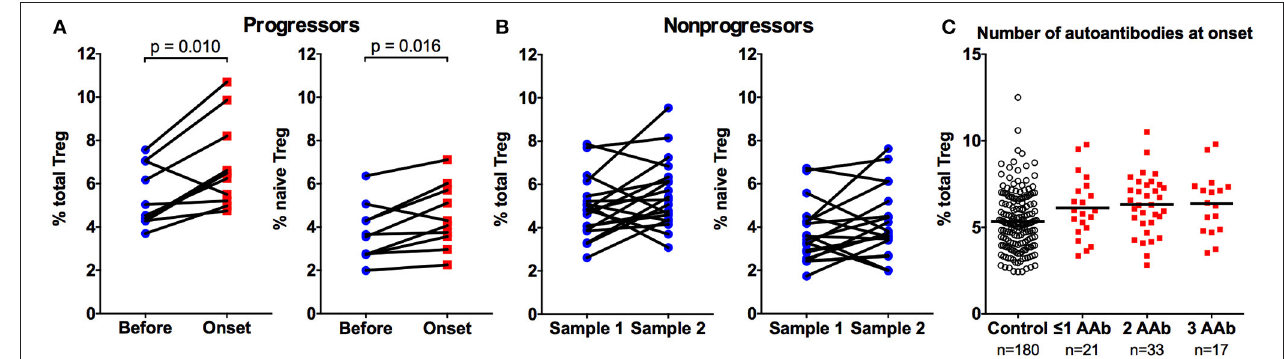
FIGURE 2 | Increase in total and naive Treg frequencies is associated with progression to clinical T1D. Two samples from ten autoantibody-positive children that progressed to T1D were analyzed 3–30 (mean 13) months apart for total ( A , left) and naive ( A , right) CD4 + CD25 + CD127low Treg frequencies. Two samples from 19 autoantibody-positive children that did not progress to T1D were analyzed as a control 3-33 (mean 18) months apart for total ( B , left) and naive ( B , right) Treg frequencies. P values from paired t -tests are indicated. The frequencies of total Tregs in children stratified by the number of biochemical autoantibodies (IAA, GADA, or IA2A) at disease onset (C)